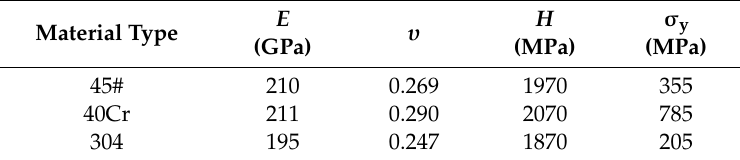
Table 1. Material parameters of the three steel materials.